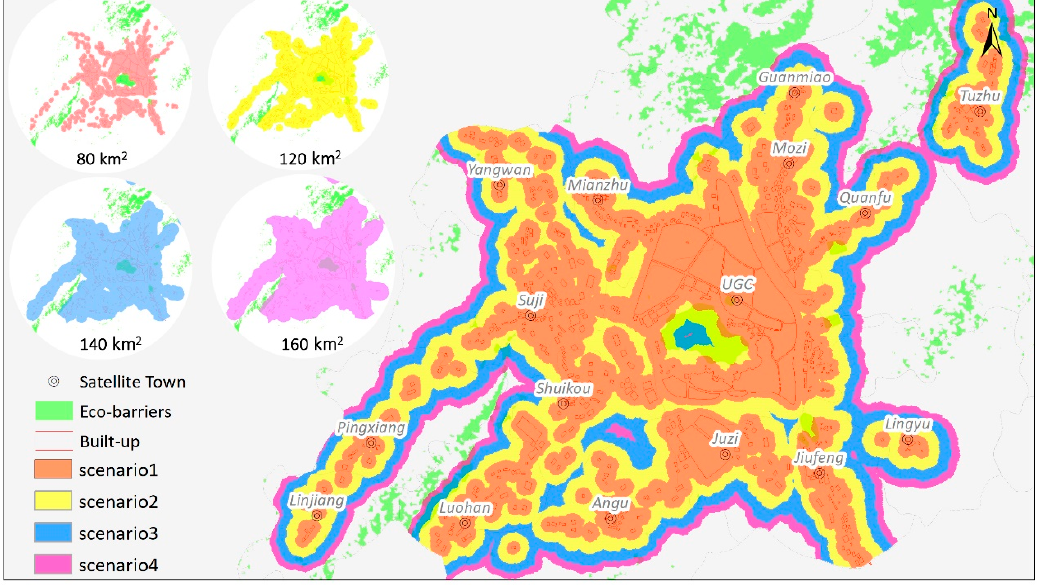
Figure 11. Connectivity and scales in the different scenarios.